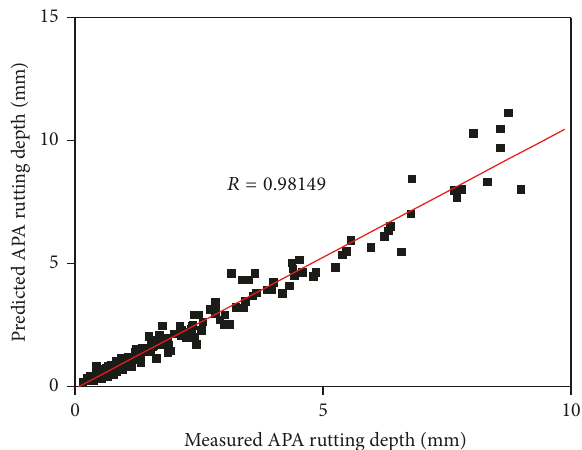
Figure 15: Comparison of measured and predicted APA rutting